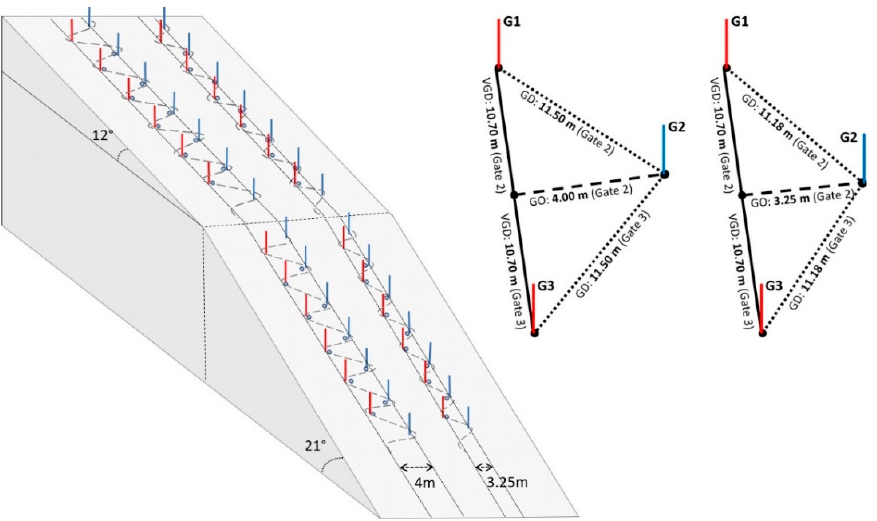
Figure 2. On-hill measurement setup. Left : schematic illustration of the four 10-gate SL courses. Right top: illustration of the course setting characteristics, characterized by gate distance (GD), gate offset (GO) and vertical gate distance (VGD).